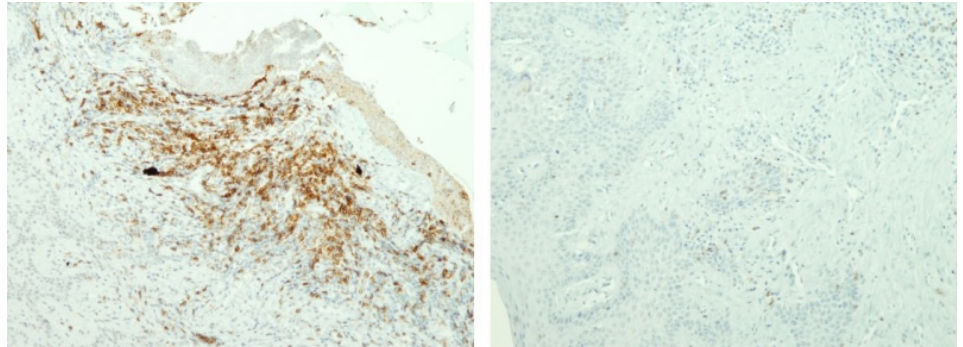
Figure 1. Comparison of immunohistochemical parameters between sensitised and non-sensitised subjects (bars represent means and whiskers 95% confidence intervals).